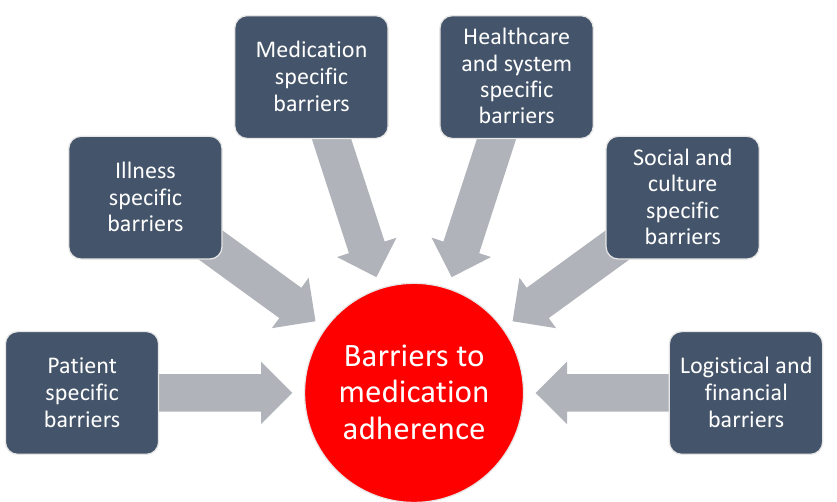
Figure 2. The identified key barriers to medication adherence based on the included qualitative studies ( n = 89).